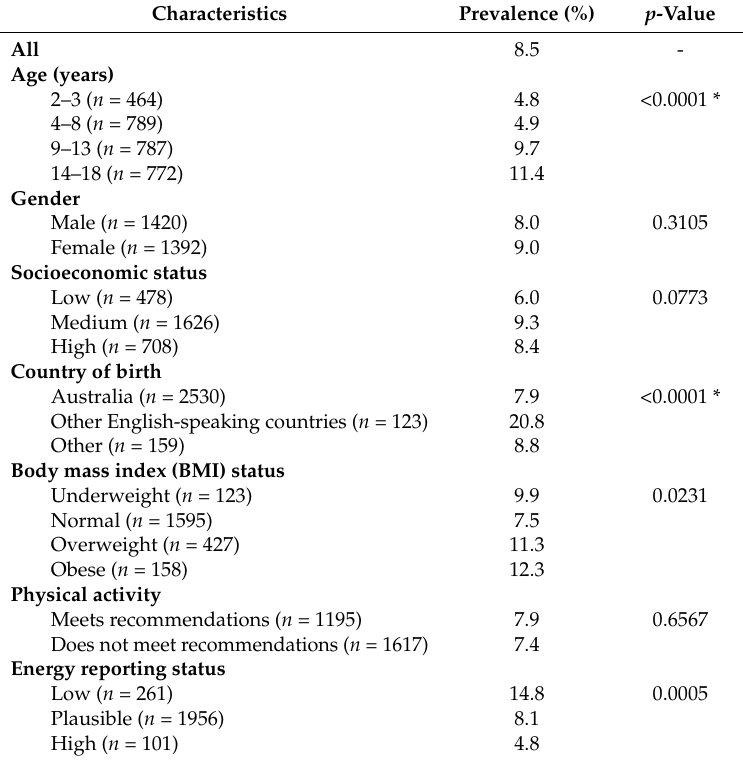
Table 1. Prevalence of non-nutritive sweetener consumption per day of Australian children aged 2–18